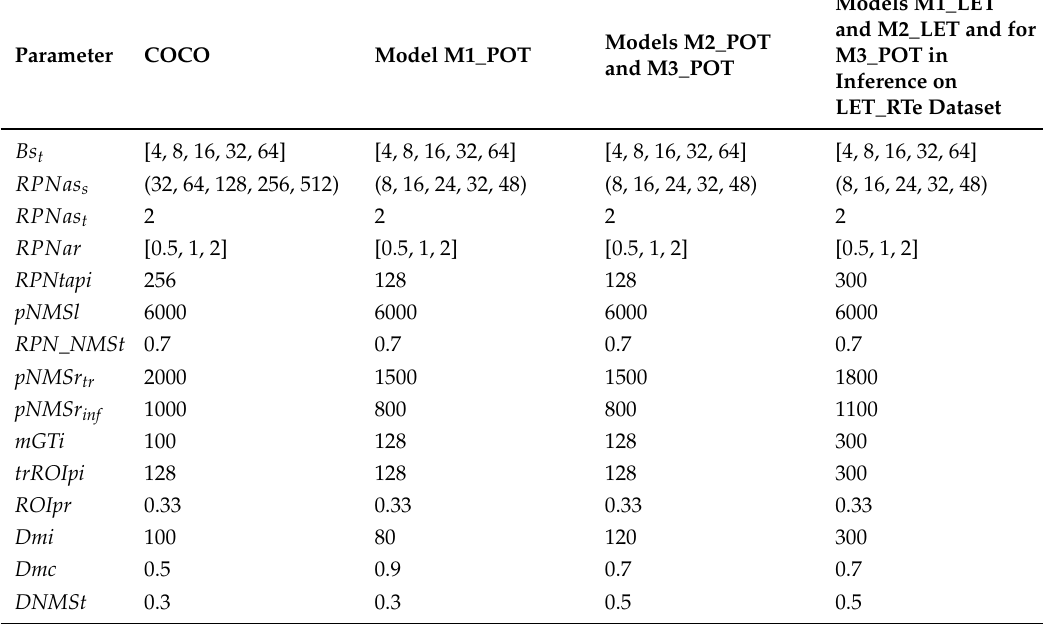
Table 3. Derived parameters for each Mask R-CNN model thanks to the architecture examination and hyper parameters selection (see Sections 2.2.1 and